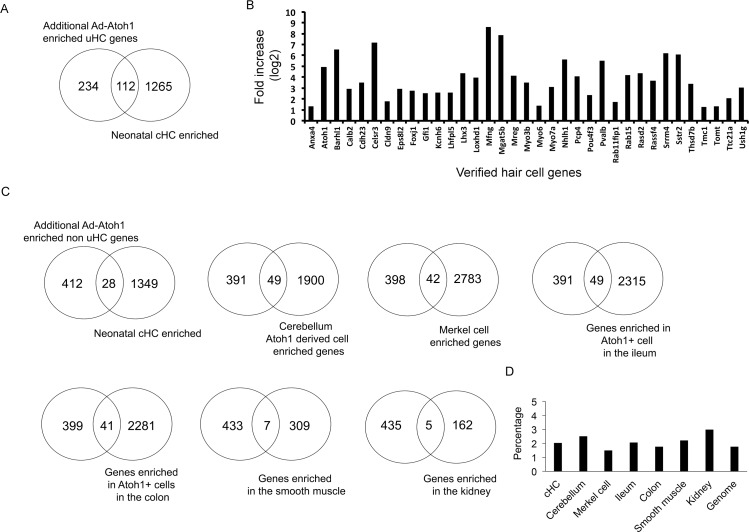
Validation of genes up-regulated in Ad-Atoh1 treated supporting cells.(A) Venn diagram comparing hair cell genes induced by Atoh1 transduction of supporting cells with genes enriched in neonatal cochlear hair cells (1377 genes, Fold change >3, adj-P <1E-10). 112 of the 346 Atoh1-induced genes were also present in neonatal cochlear hair cells B) Validation of 35 hair cell genes showing expression in Ad-Atoh1 infected cells relative to control Ad-tdTomato infected cells. (C) Analysis of 440 genes induced by Atoh1 in supporting cells that are not normally present utricle hair cells. The Venn diagrams show the intersection of these 440 genes with genes enriched in other Atoh1-expressing cell types (neonatal cochlear hair cells, cerebellum, Merkel cells, secretory cells of the Ileum and colon) as well as two cell types that do not express Atoh1 (smooth muscle and kidney). (D) Graph showing the intersection of the 440 genes induced by Atoh1 in supporting cells that are not normally present utricle hair cells with other cell types. There is no significant difference in up-regulated genes in Atoh1-expressing versus Atoh1 non-expressing cell types.